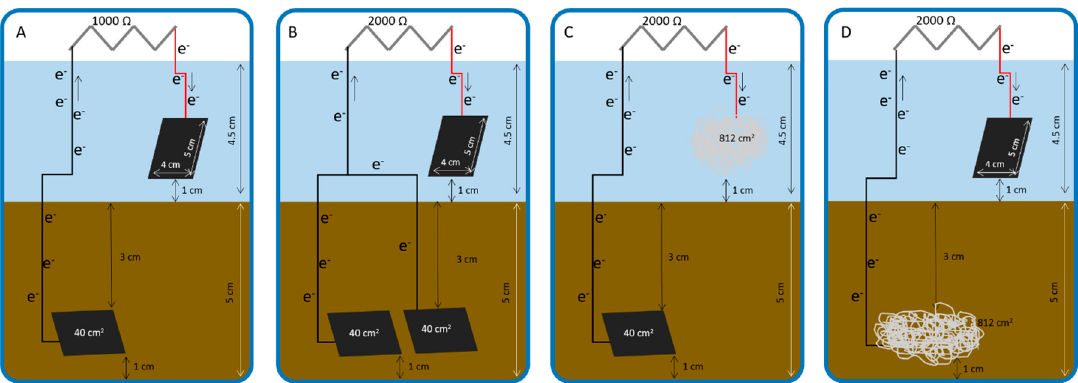
Figure 1. Sediment Microbial Fuel Cell (SMFC) experimental set-up; ( A ) one carbon Toray anode and one carbon Toray cathode; ( B ) two carbon Toray anodes and one carbon Toray cathode; ( C ) one carbon